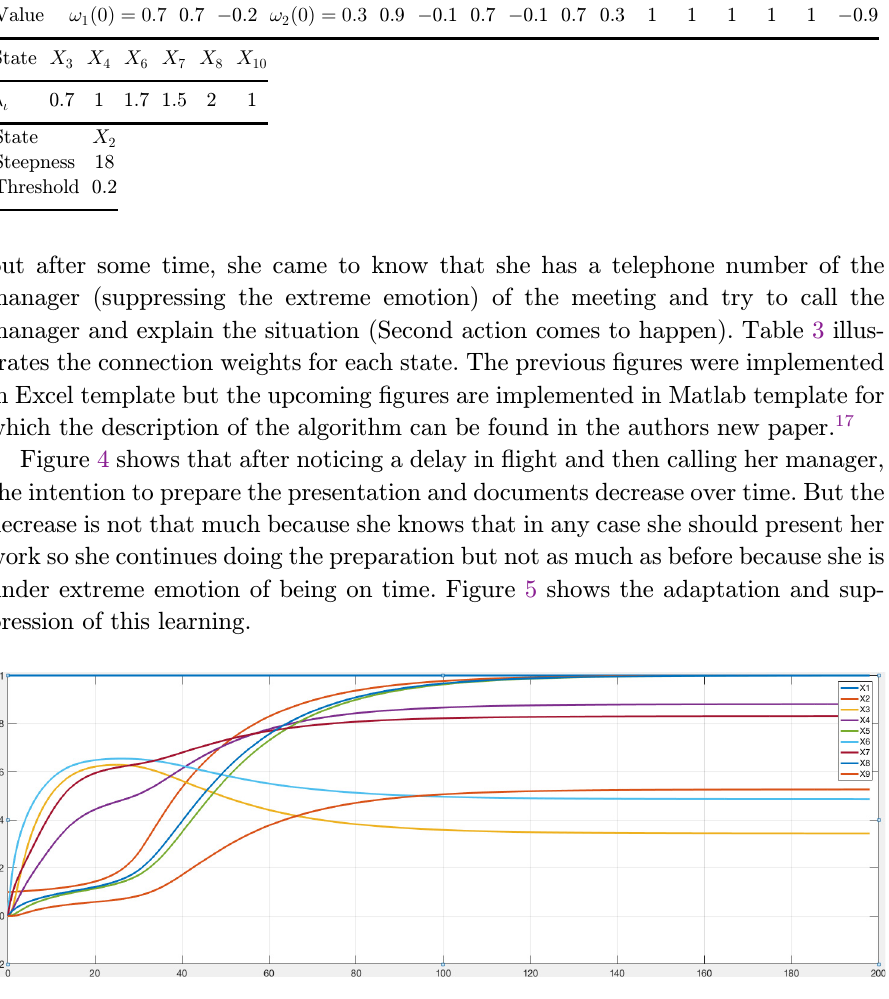
Fig. 4. Simulation results of working under an extremely stressful condition (Scenario 2): state.